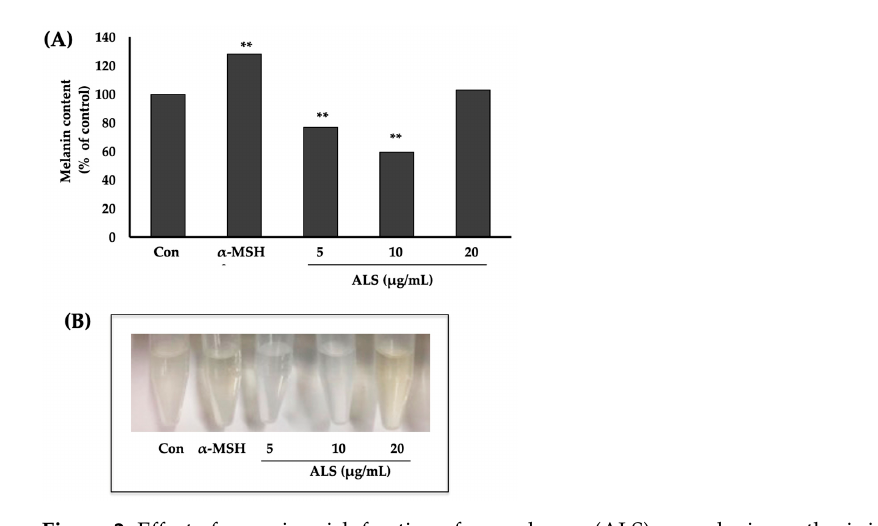
Figure 2. Effect of saponins-rich fraction of argan leaves (ALS) on melanin synthesis in B16 cells. B16 cells were seeded at a density of 5 × 10 5 cells per 100 mm Petri dish. After overnight incubation, cells were treated with 5 µg/mL, 10 µg/mL, or 20 µg/mL of ALS. ( A ) Melanin content was quantified using melanin assay and expressed as melanin content/cell. ( B ) Melanin extracted from B16 cells dissolved in 8N NaOH. Data are expressed as mean ± SD ( n = 5). ** indicates significance at p < 0.01.